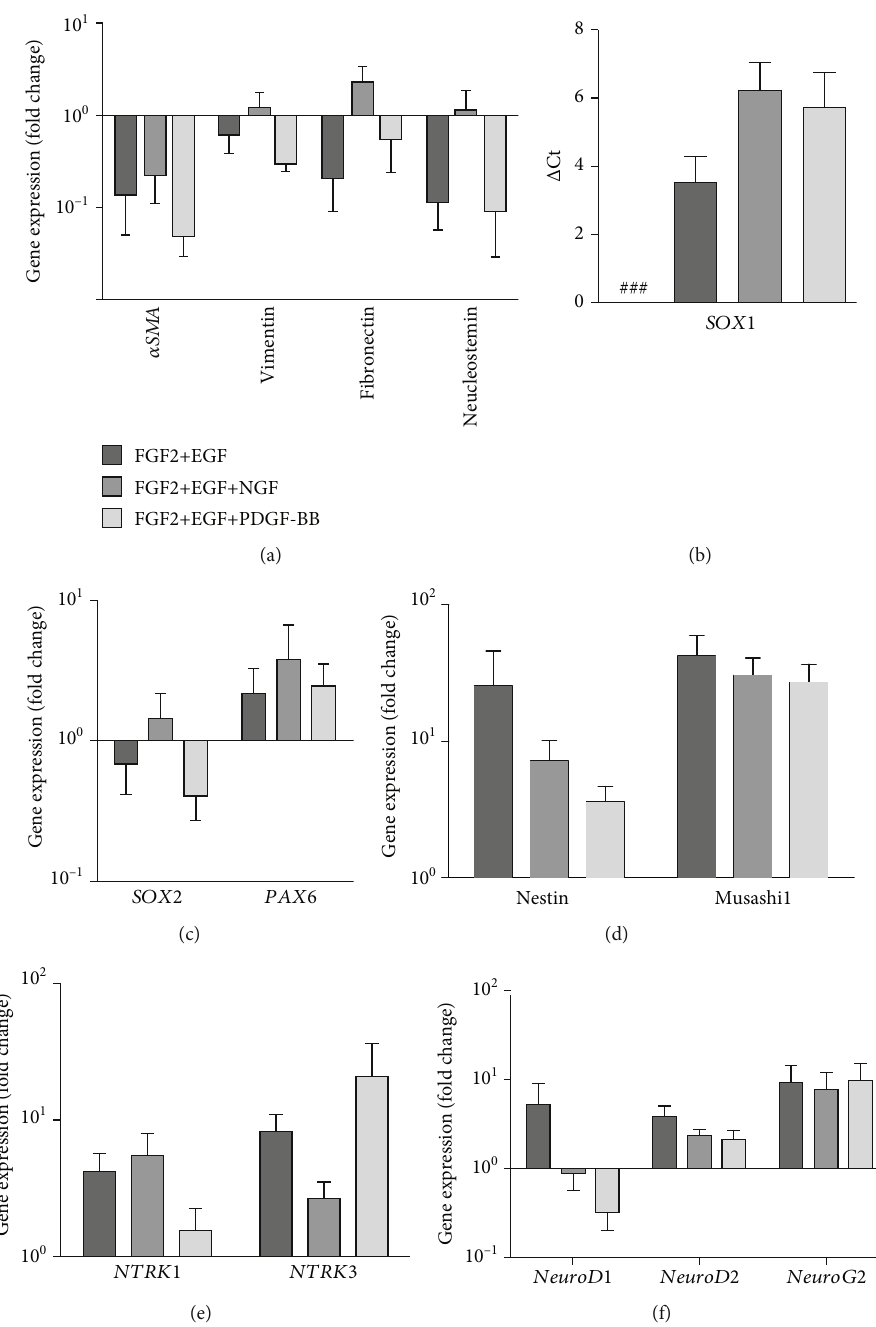
Figure 4: Gene expression pro fi le of WJ-MSCs primed neuroectodermal cells. Panel A: expression pro fi le of MSC-speci fi c genes. Panel B: expression pro fi le (delta Ct) of SOX1 in WJ-MSCs and in primed neuroectodermal cells in all three-di ff erentiation condition. “ ### ” indicates no ampli fi cation observed in WJ-MSCs. Panel C: expression pro fi le of neural progenitor-speci fi c transcription factors. Panel D: expression pro fi le of neural stem cell-speci fi c genes. Panel E: expression pro fi le of neuronal receptor-speci fi c genes. Panel F: expression pro fi le of neuron-speci fi c transcription factors. GAPDH was used as normalization control. Bar 1 (cells induced with FGF2 and EGF), Bar 2 (cells induced with FGF2, EGF, and NGF), and Bar 3 (cells induced with FGF2, EGF, and PDGF-BB). Relative fold changes of gene expressions are shown as compared to that in WJ-MSCs. ( mean ± SEM , n = 4